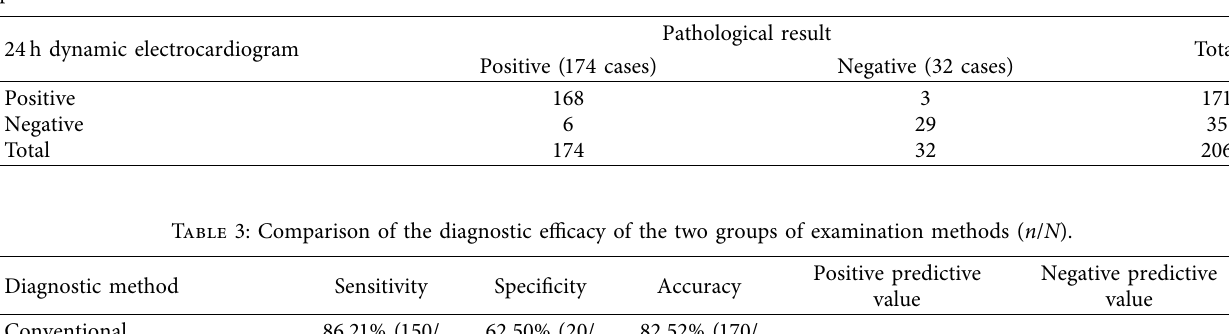
Table 2: Te diagnostic efcacy of 24 h dynamic electrocardiogram in asymptomatic myocardial ischemia with arrhythmia in elderly patients with CHD.